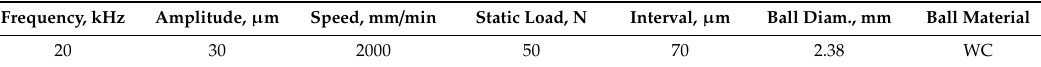
Table 2. UNSM treatment parameters.